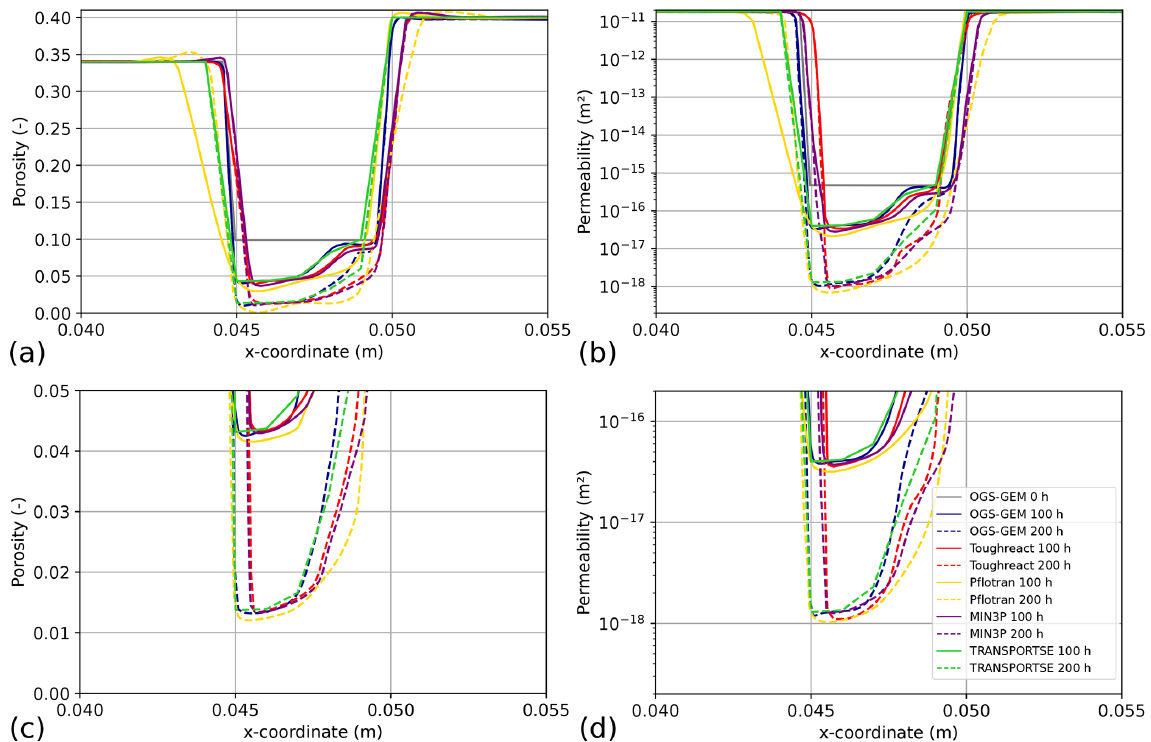
Figure 12. (a) , (c) Porosity and (b) , (d) permeability along the relevant Line 1 section in the flow cell at simulation times of 100 and 200h calculated by TRANSPORTSE-PHREEQC in comparison against the results documented by Poonoosamy et al.